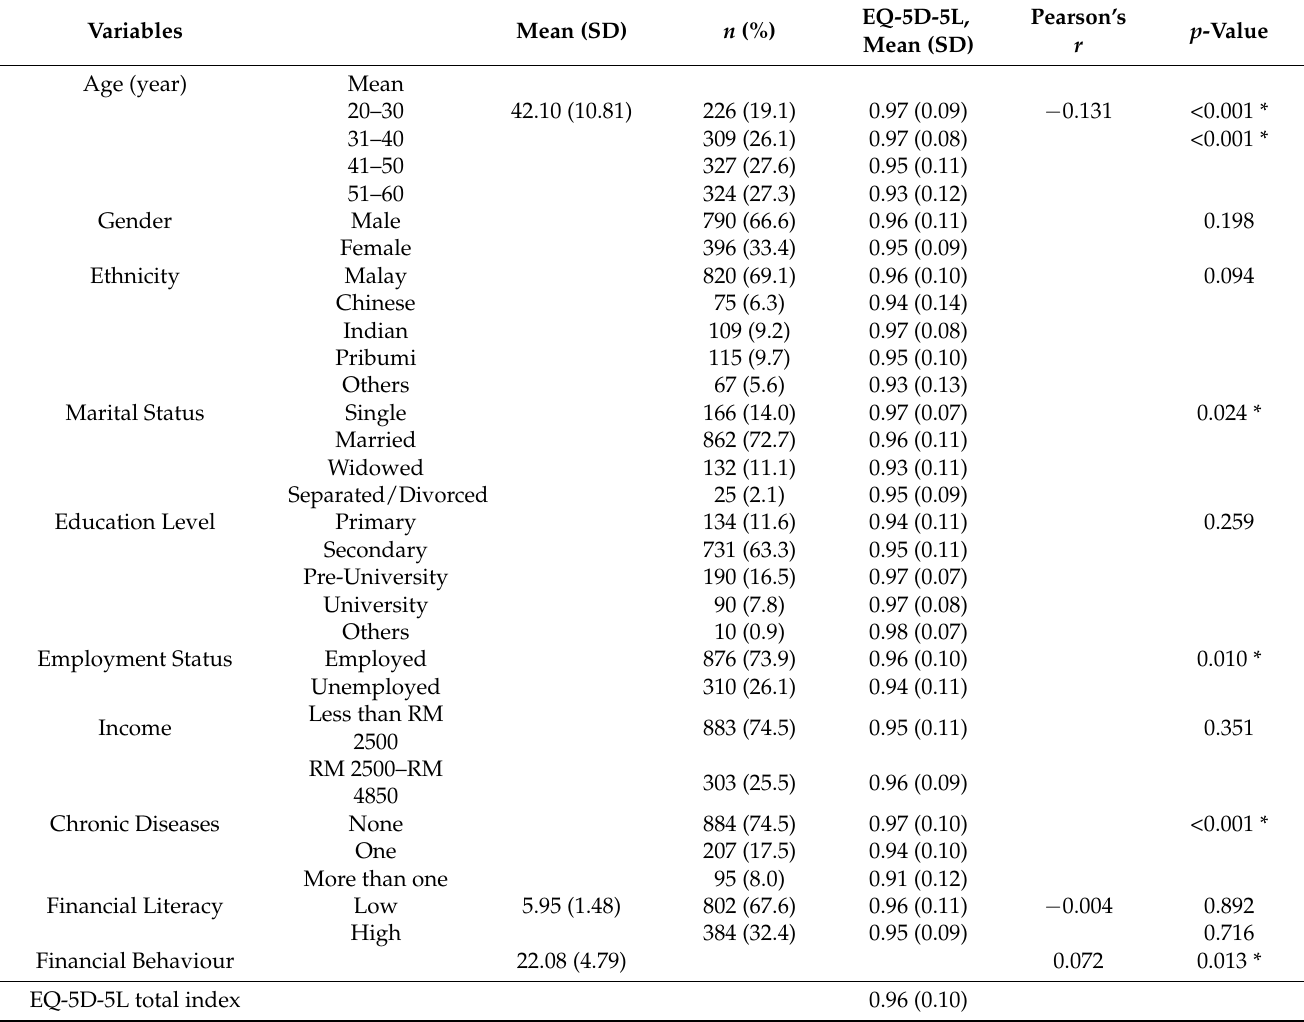
Table 1. Characteristics of productive B40 respondents based on HRQOL ( n =